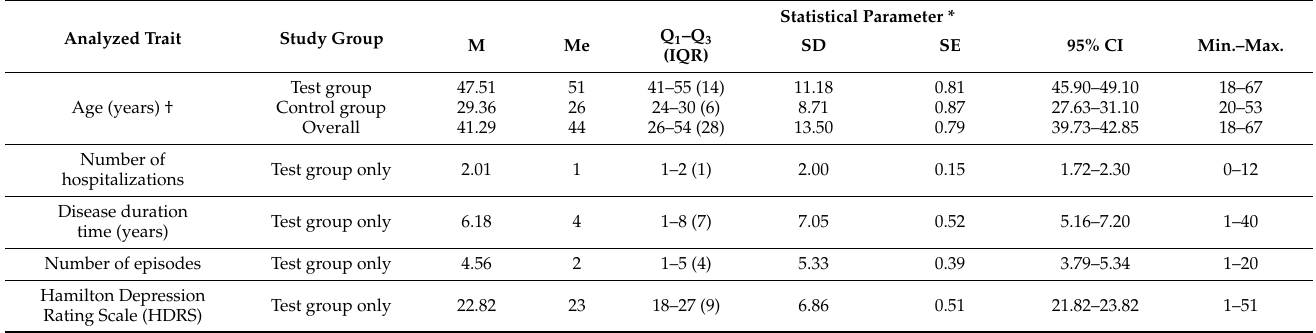
Table 1. Demographic characteristics of the study cohort by nosology